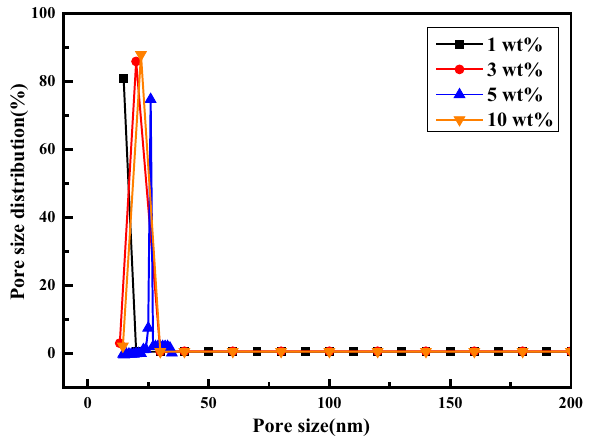
Fig. 8 Contact angle of PVDF flat sheet membrane with different PVP